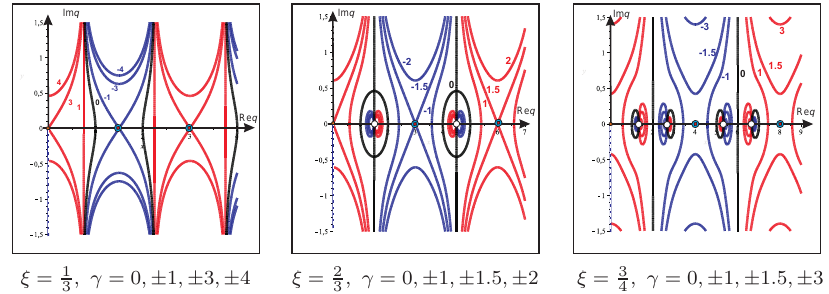
Figure 4. Contour lines of the function Re γ c ( πq ) for various ξ